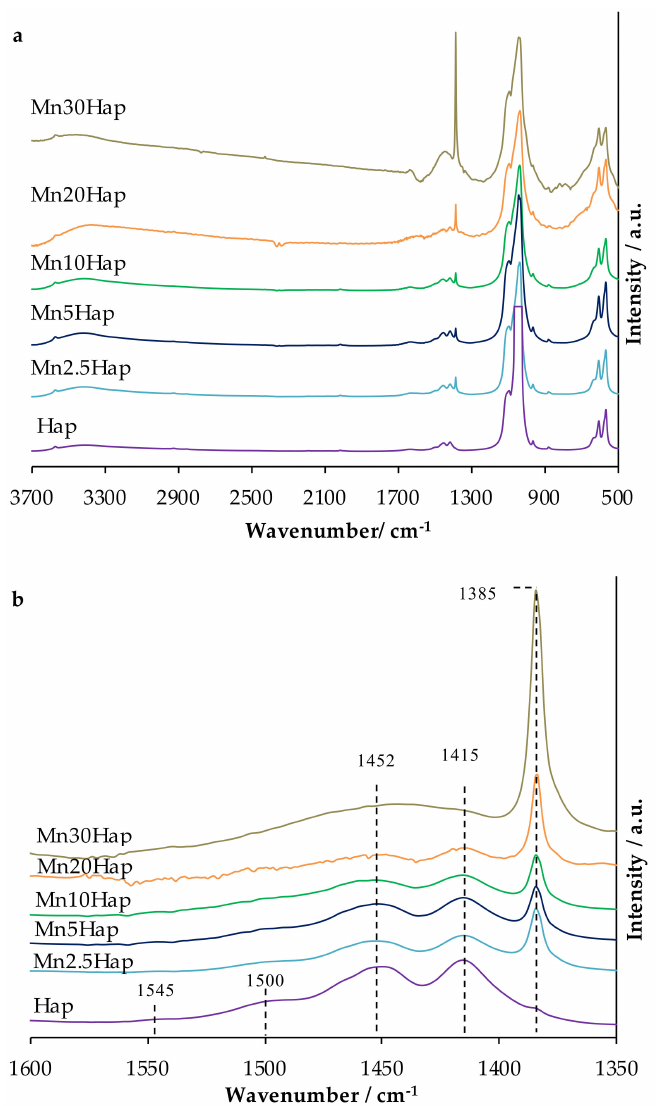
Figure 2. Fourier-Transform Transmission Infrared (FT-IR) spectra of Hap and Hap supported Mn catalysts with di ff erent loadings in the ( a ) 500–3700 cm − 1 and ( b ) 1350–1600 cm − 1